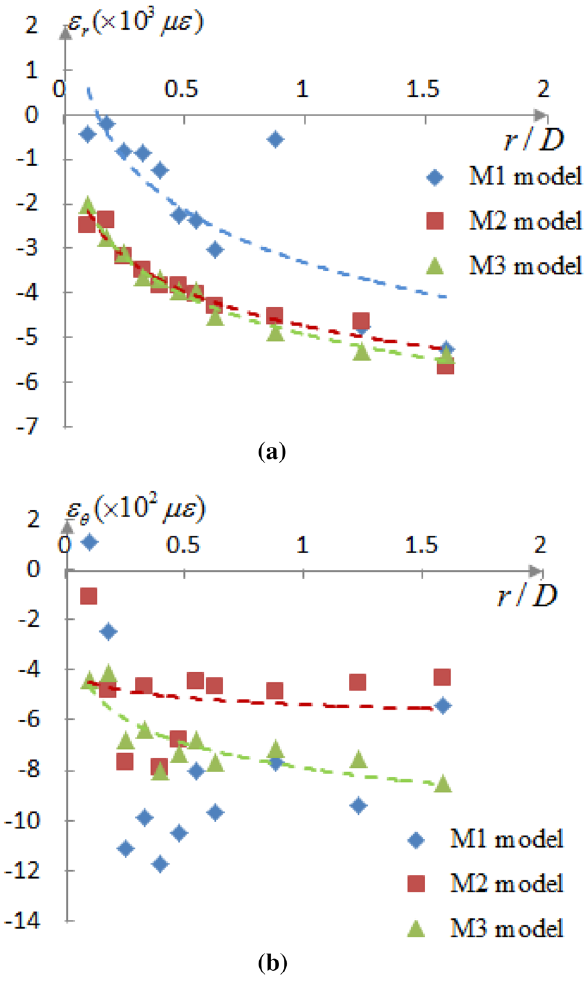
Fig. 13 Comparative analysis of the a radial and b circumferential strains at the bottom of the tunnels in three models after excavation